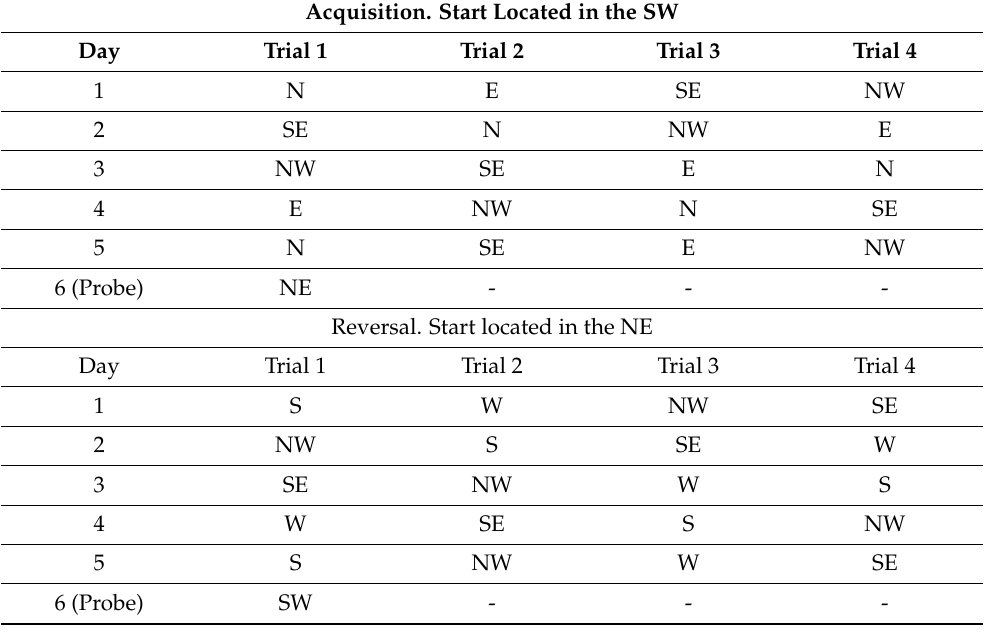
Table 2. Scheme of Morris water maze experiment for study of reference memory with indication of starting point and goal platform.